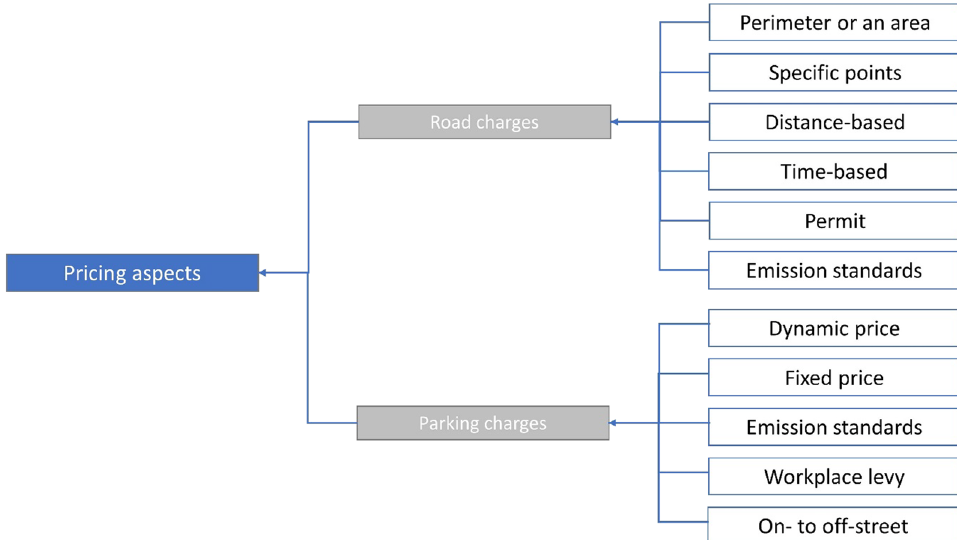
Fig. 4 Schematic for the UVAR taxonomy for the category of pricing